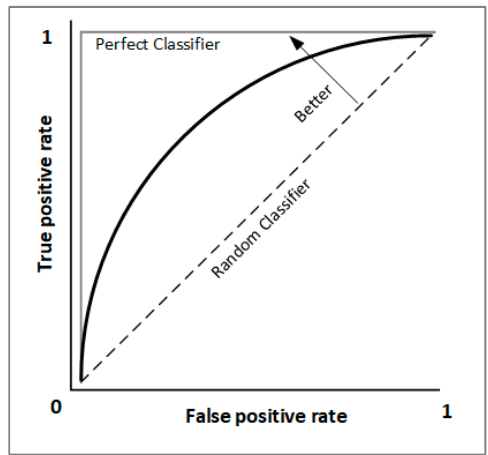
Figure 5. Receiver operating characteristic curve.